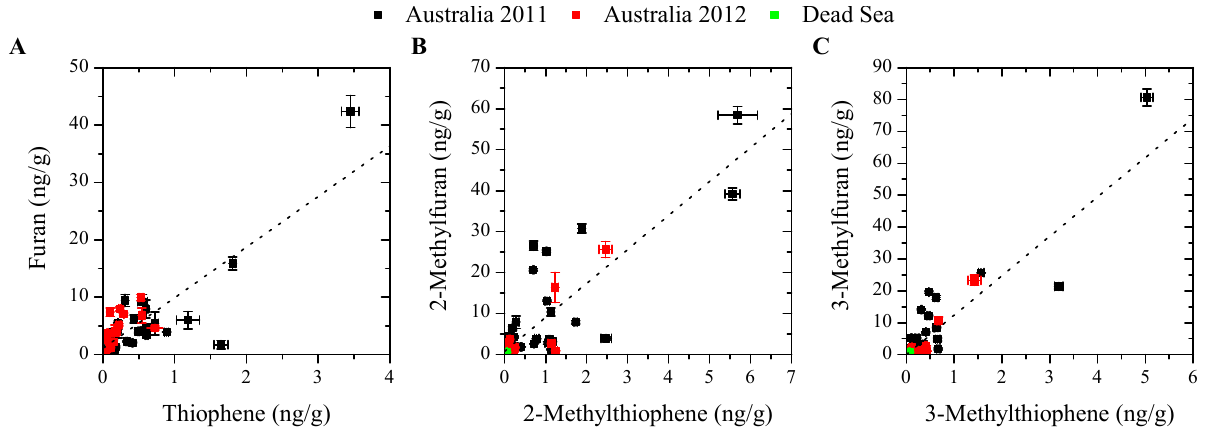
Figure 7. Correlation between the emission of related heterocyclic aromatic compounds such as (A) furan and thiophene, (B) 2-methylfuran and 2-methylthiophene and (C) 3-methylfuran and 3-methylthiophene from sediment samples (Australia 2011: black; Australia 2012: red; Dead Sea 2012: blue). Data points represent mean values with error bars indicating standard deviations from triplicate measurements.